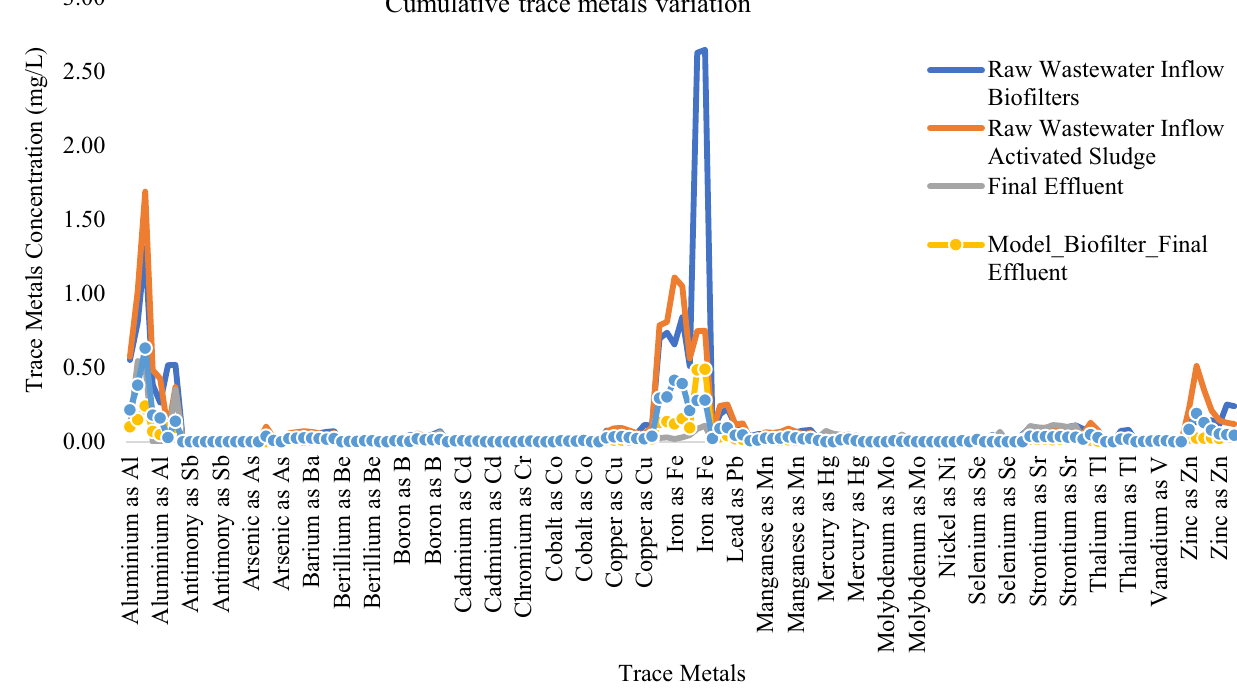
Fig. 4 Cumulative trace metals variation in the biofilm and activated sludge wastewater treatment plants